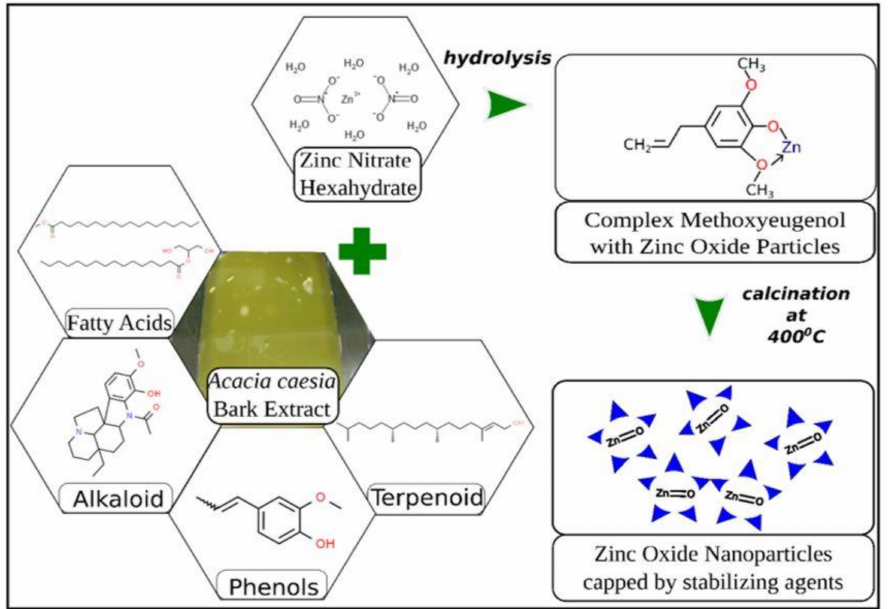
Figure 11. The mechanism of formation of ZnO nanoparticles using Acasia caesia [21]. Saini et al. [26] synthesised ZnO NPs of blocks/bars of sizes of 40–120 nm using Azadira indica [26]. Umar et al. [119], using Sapindus rarak DC fruit extract,